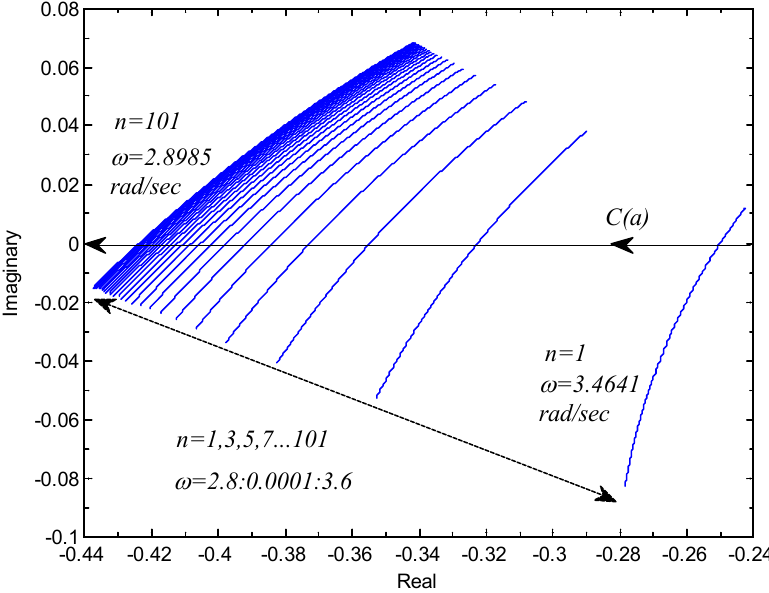
Figure 14. A Loci for different values of n for Equation (37) where